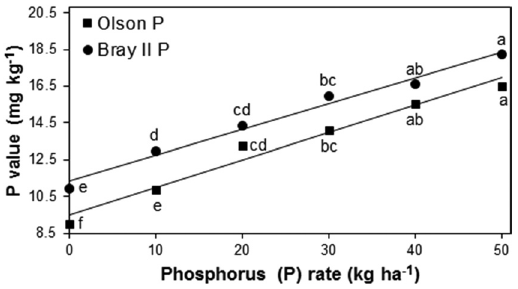
Figure 3: Response of available soil phosphorus to P fertilizer rate.